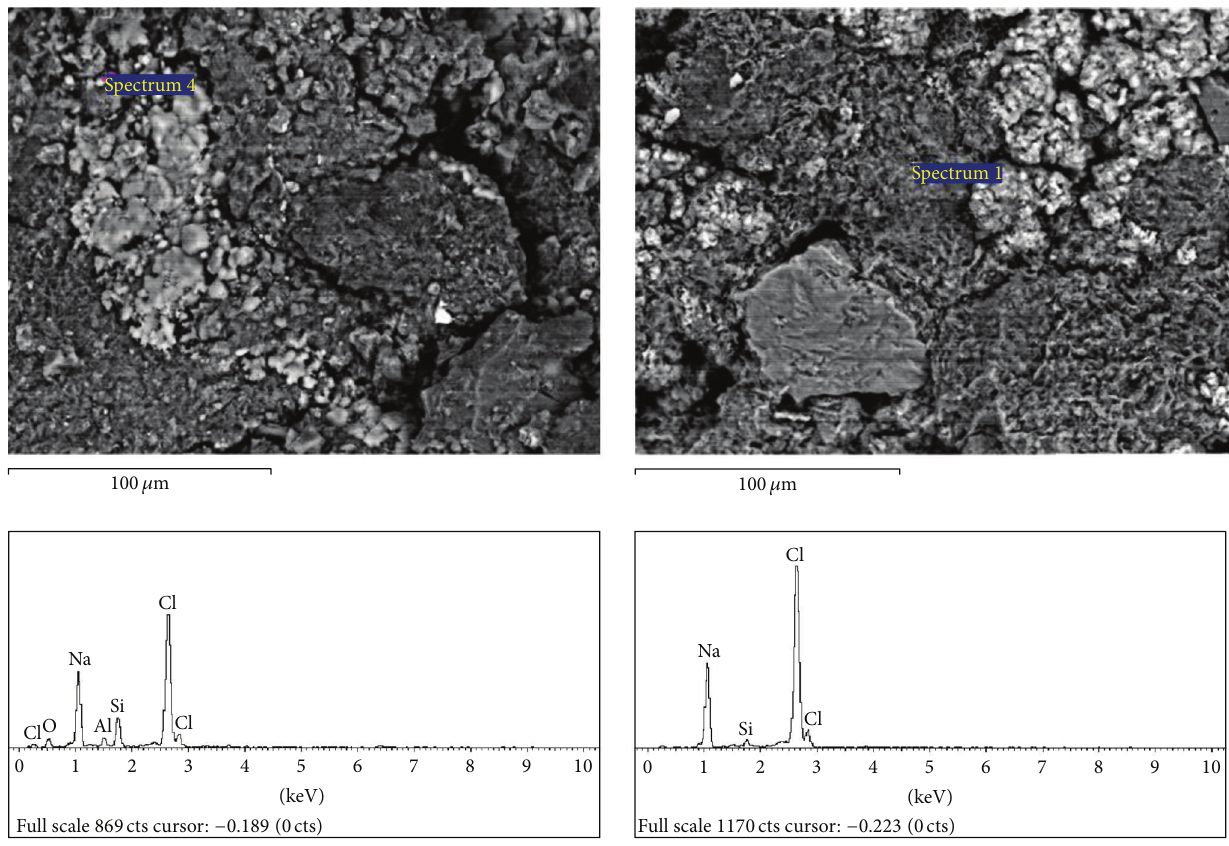
Figure 5: SEM-EDS images of the bentonite particles (A-S and B-S) hydrated with NaCl.